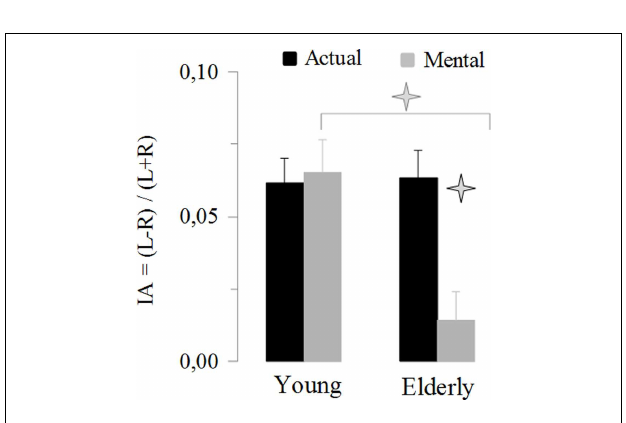
FIGURE 4 |Average values ( ± SE) of the index of asymmetry [IA = ( L − R )/( L + R )] for the actual and mental movements in both groups .The asterisks (*) indicate significant differences ( P < 0.01).